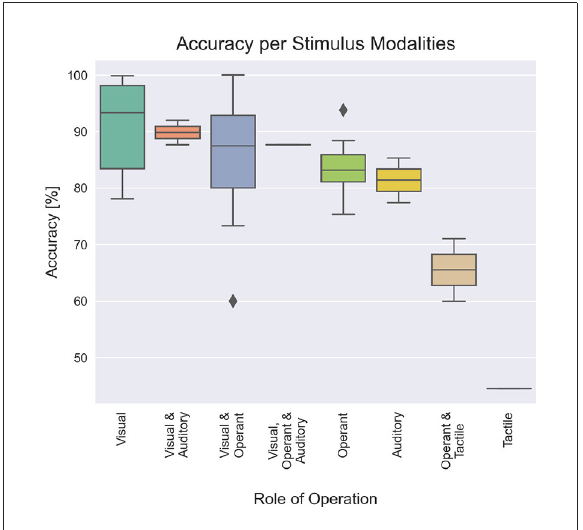
FIGURE10 Average accuracy per stimulus